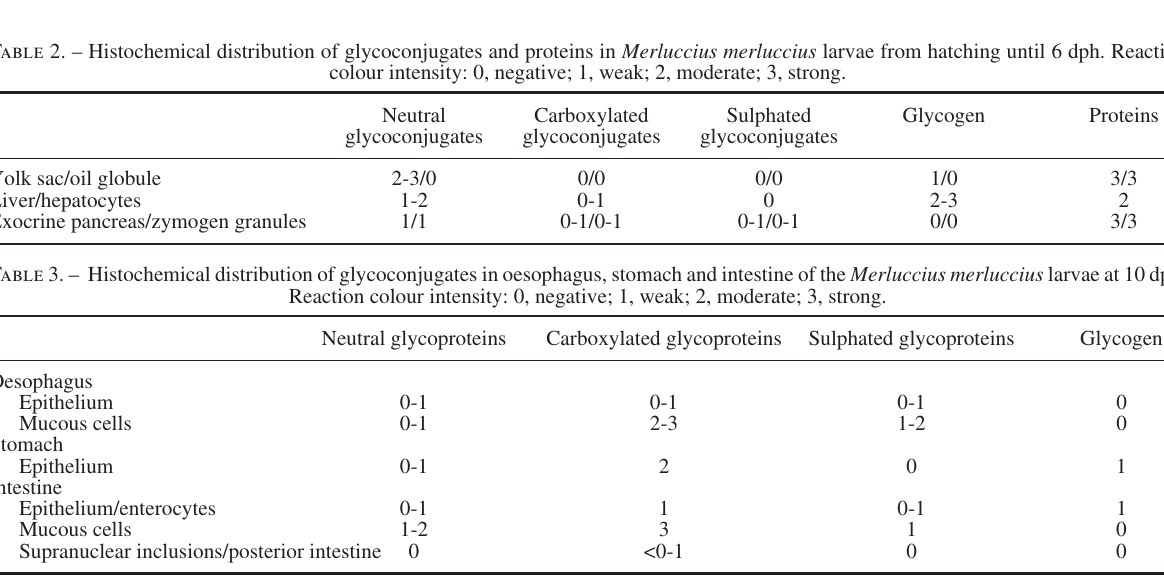
Table 4. – Histochemical distribution of proteins in oesophagus, stomach and intestine of the Merluccius merluccius larvae at 10 dph. Reac- tion colour intensity: 0, negative; 1, weak; 2, moderate; 3,